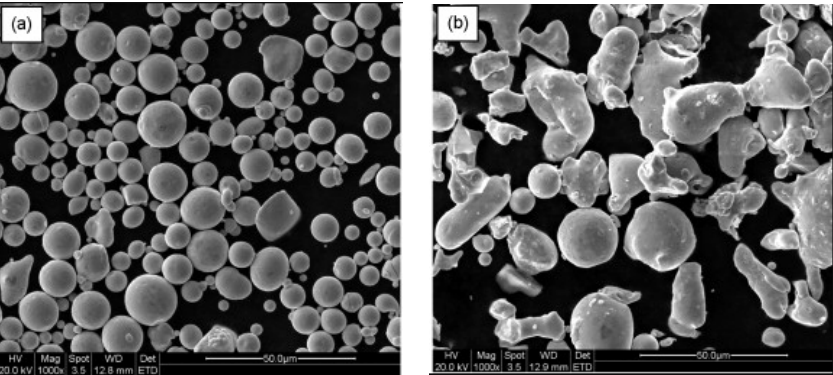
Figure 7. SEM images showing characteristic morphologies of 316L SS powder; ( a ) gas atomized powder, ( b ) water atomized powder [72].